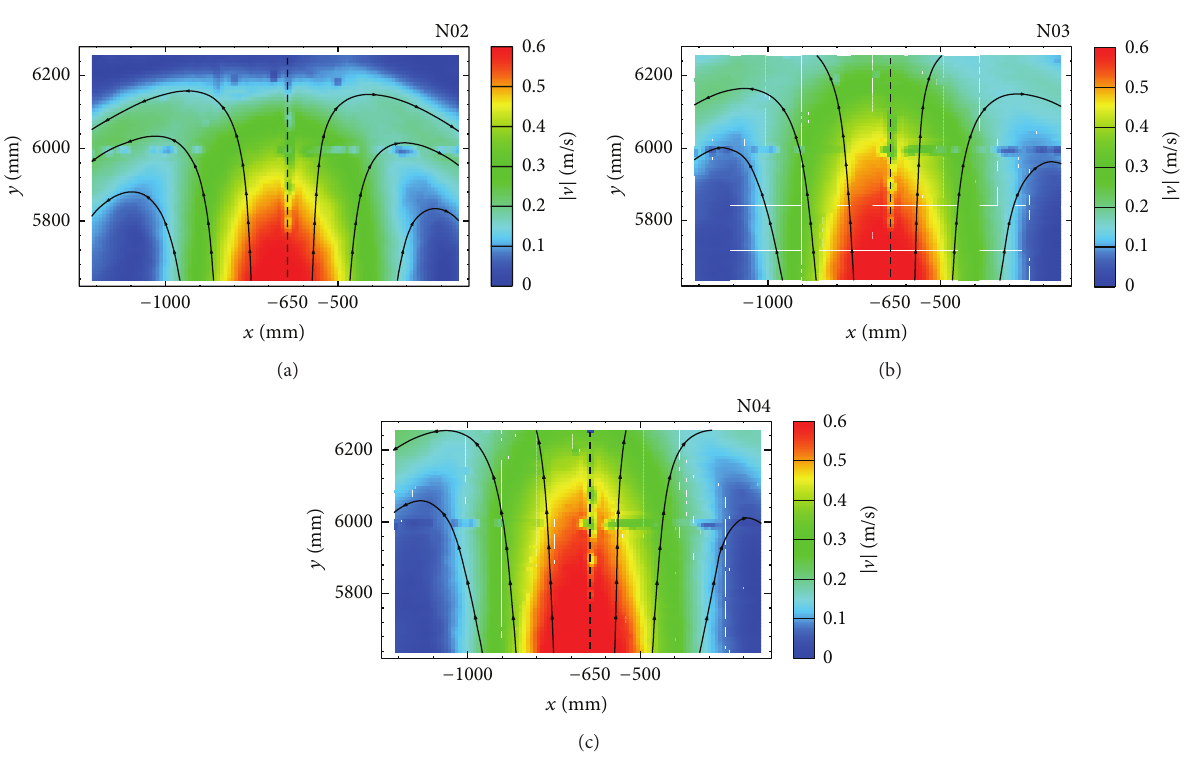
Figure 12: Development of the velocity magnitude field for position B during time steps 𝑡 = 715 , 978 , and 1213 s.